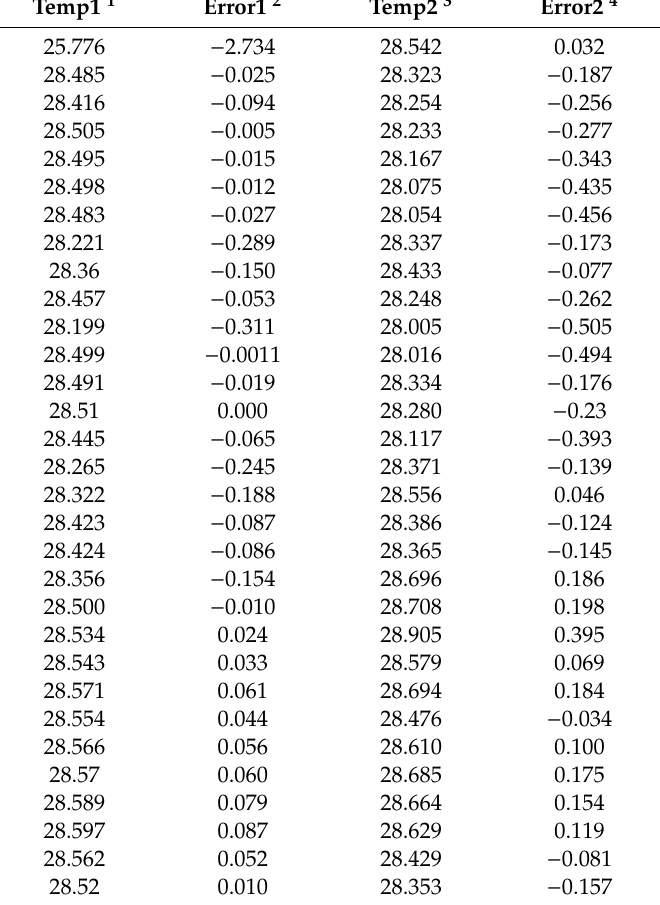
Table 2. The data of using di ff erent algorithms to process temperature detected by ocean conductivity temperature depth